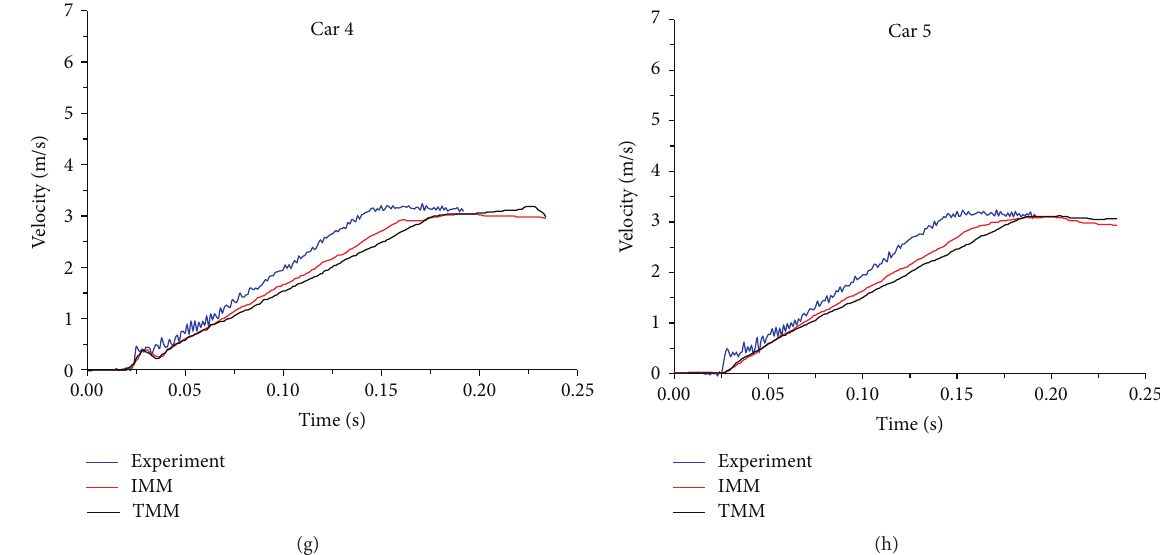
Figure 6: The comparison of velocity between experiment and simulations.